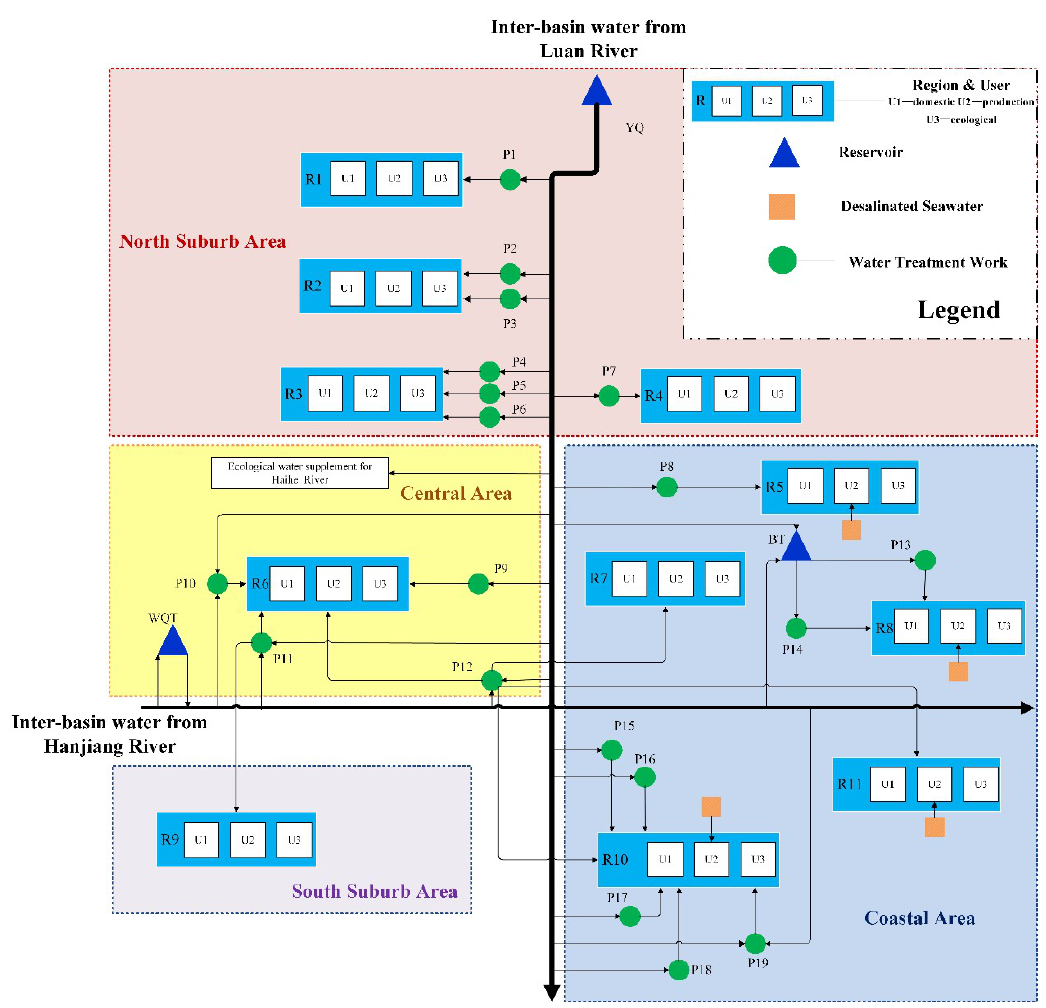
Figure 2. The topology network of the water supply system of Tianjin.